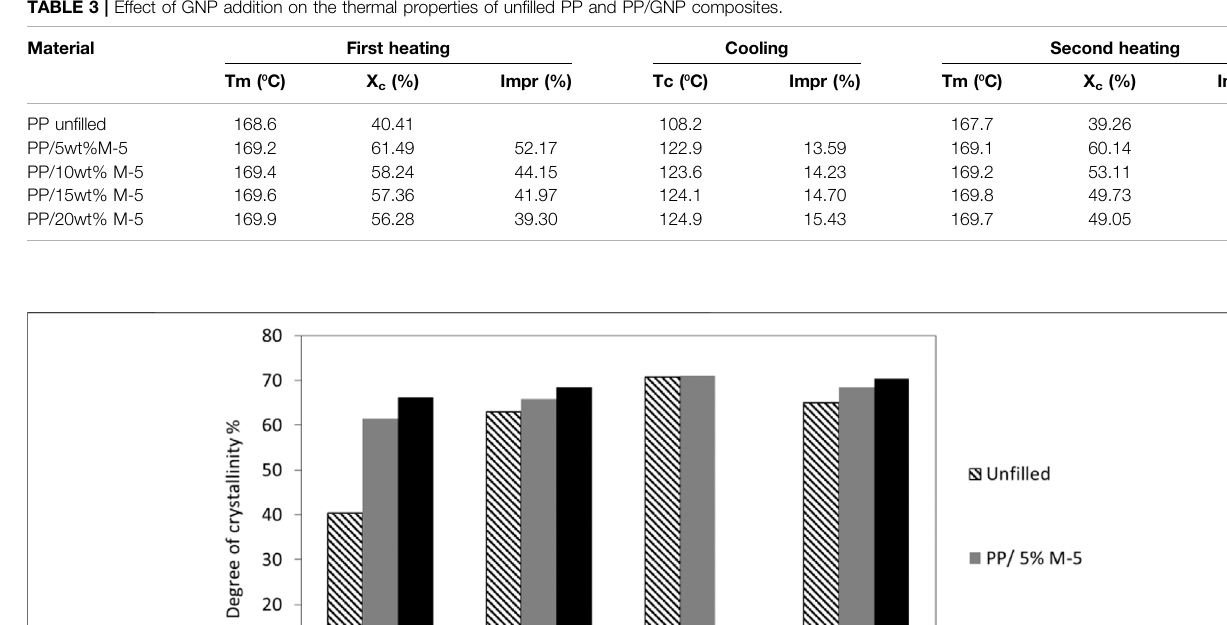
Frontiers in Materials |